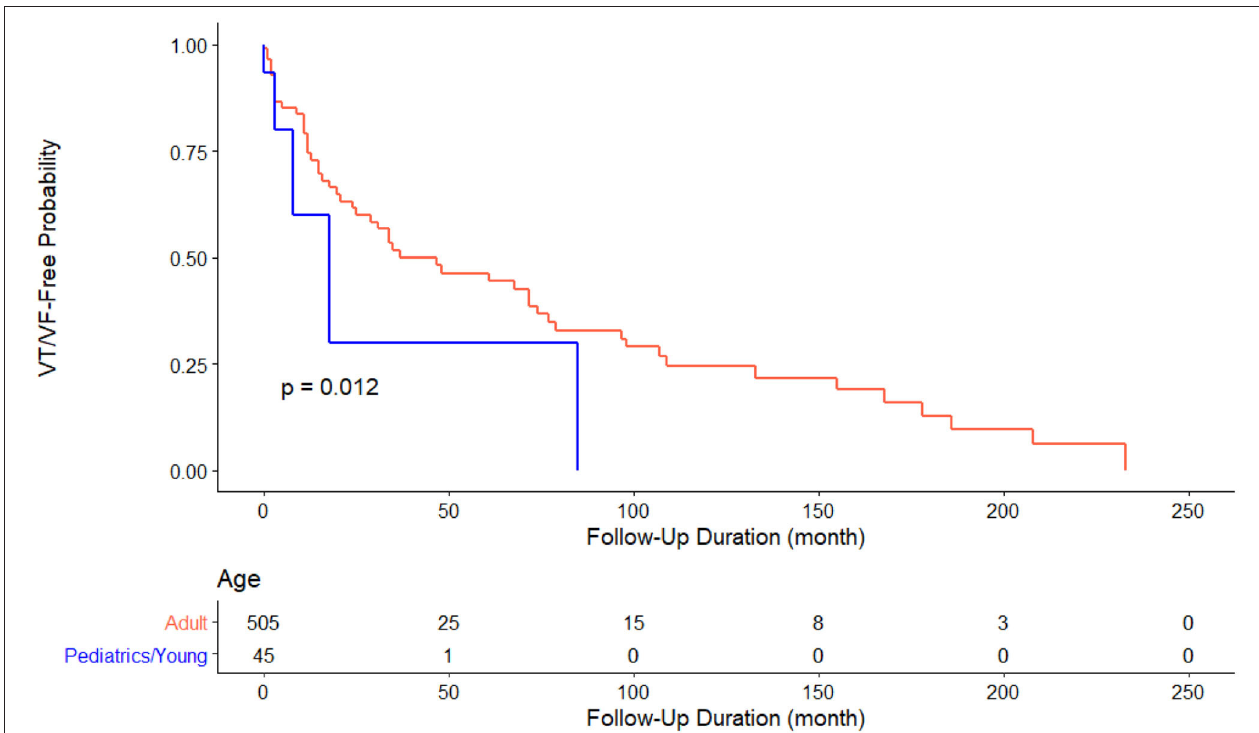
FIGURE 1 | Kaplan-Meier survival curve for paediatric/young and adult Brugada syndrome patients.